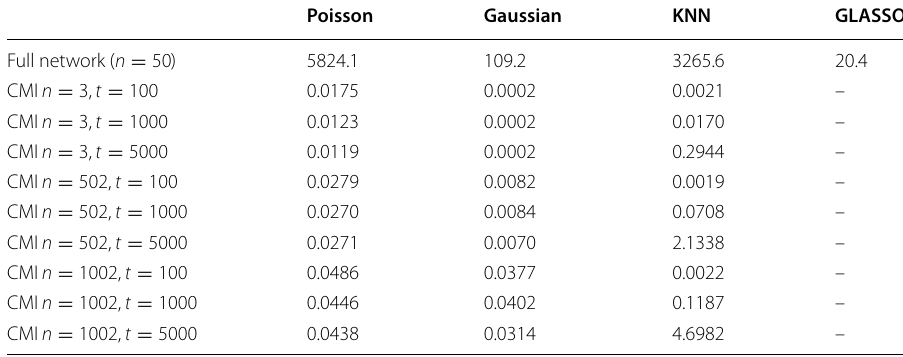
Table 1 Computational complexity